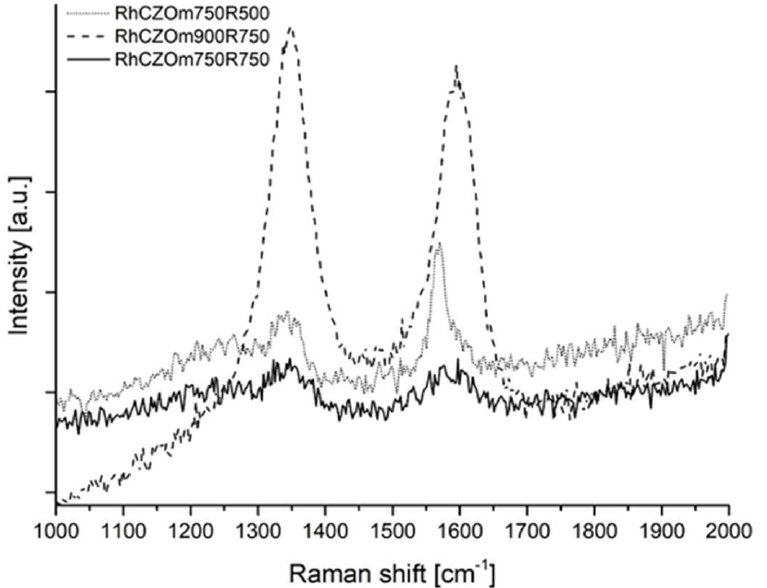
Figure 15. Raman analysis of the spent catalysts Rh-CZO-m750R500, CZO-m750R750 and Rh-CZO- m900R750.